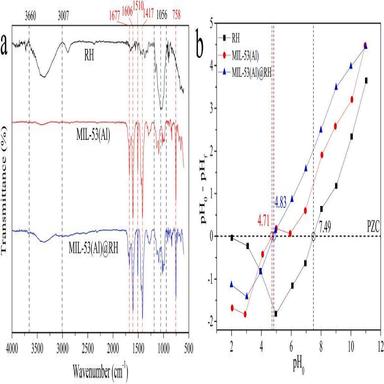
a) FTIR spectra, b) pHpzc graphical method.